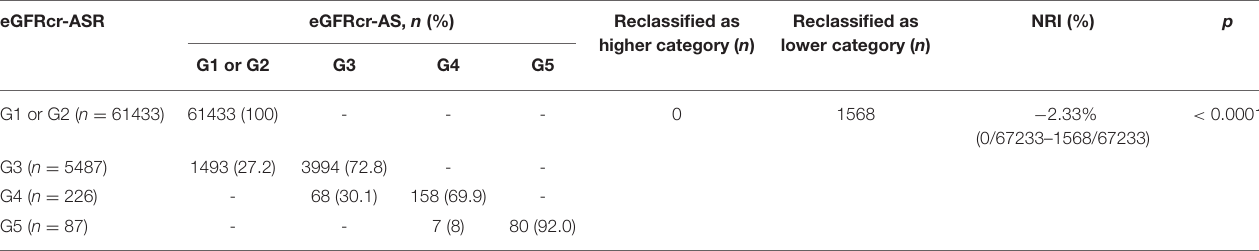
TABLE 3 | Reclassification of eGFR categories using eGFRcr-ASR and eGFRcr-AS equations. eGFRcr-ASR eGFRcr-AS, n (%) Reclassified as